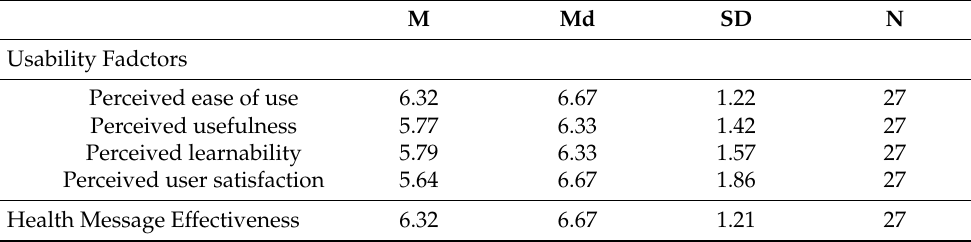
Table 1. Descriptive statistics for all variables.